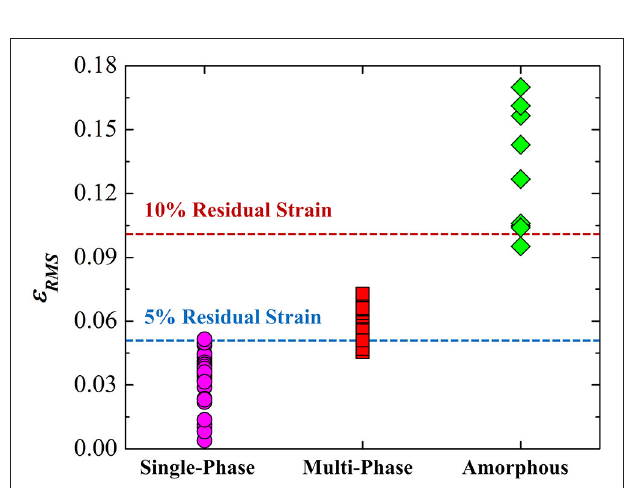
FIGURE 4 | The root-mean-square residual strain ε RMS for a variety of as-cast HEAs with difference